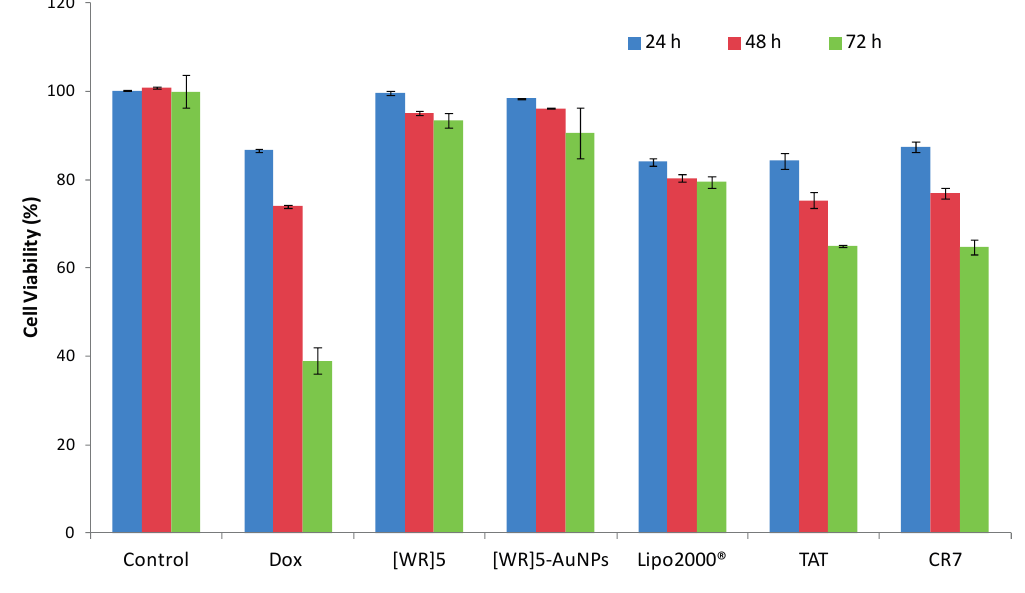
Figure 1. Cytotoxicity of the [WR] to other siRNA delivery